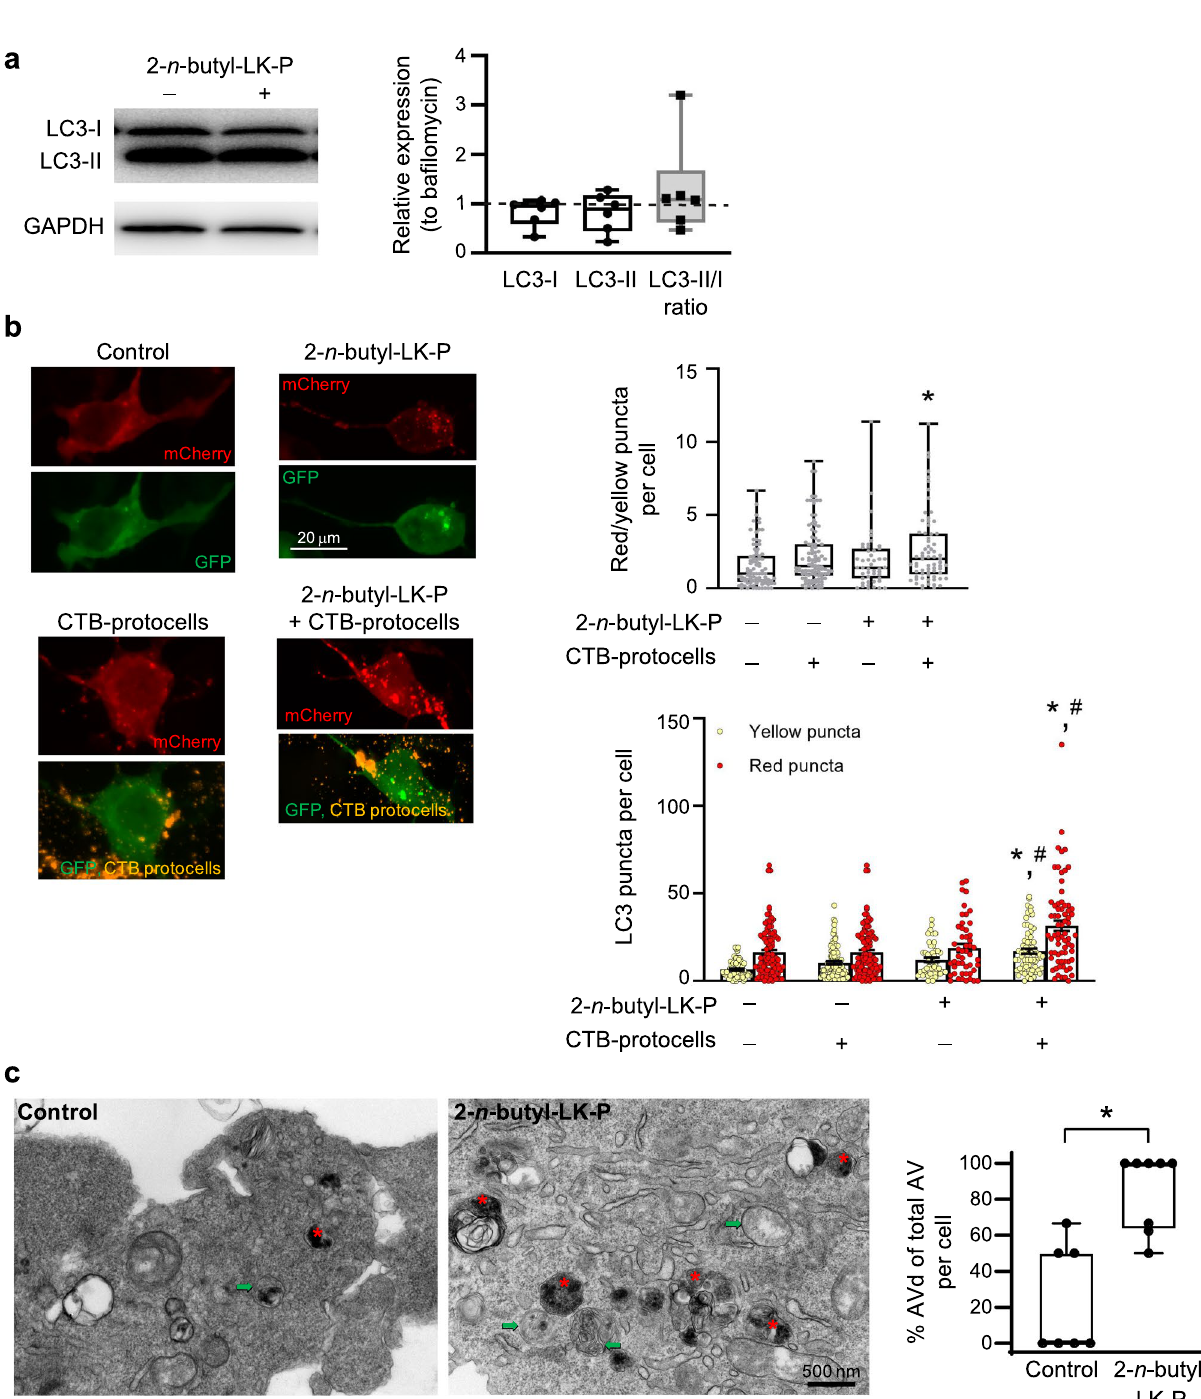
Figure 4. Autophagy flux in motor neurons after treatment with 2- n -butyl-LK-P. ( a ) Protein expression of LC3-I, LC3-II or the ratio compared to treatment with bafilomycin alone. Original uncropped blots are presented in Supplementary Fig. S4. Data are presented as a box plot, with the box extending from the 25th to 75th percentiles, the middle of the box at the median, and the whiskers at the minimum and maximum values. Each point represents protein expression from NSC-34 cells from a well of a 6-well plate; ( b ) Confocal images of NSC-34 cells transfected with mCherry-GFP-LC3 plasmid and treated with 2- n -butyl-LK-P or CTB-protocells containing 2- n -butyl-LK-P. n = 4 biological samples with a minimum of 20 cells per sample. Each point in the box plot represents a single cell. *, significantly different than control treatment (p < 0.05); # , significantly different than control CTB-protocell treatment; ( c ) EM image analysis of AVd (red asterisk) over total AV per cell after 2- n -butyl-LK-P treatment compared to control cells. n = 8 cells per group from 2 biological samples. Each point in the box plot represents a single cell. *, significantly different (p <